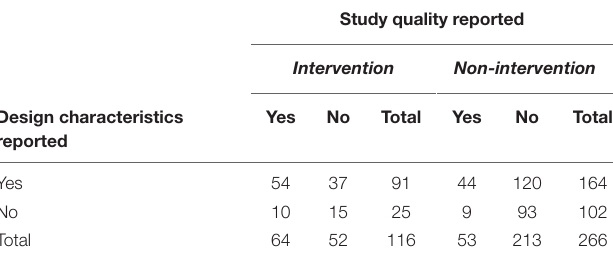
TABLE 4 | Study design characteristics by PSQ in intervention and non-intervention